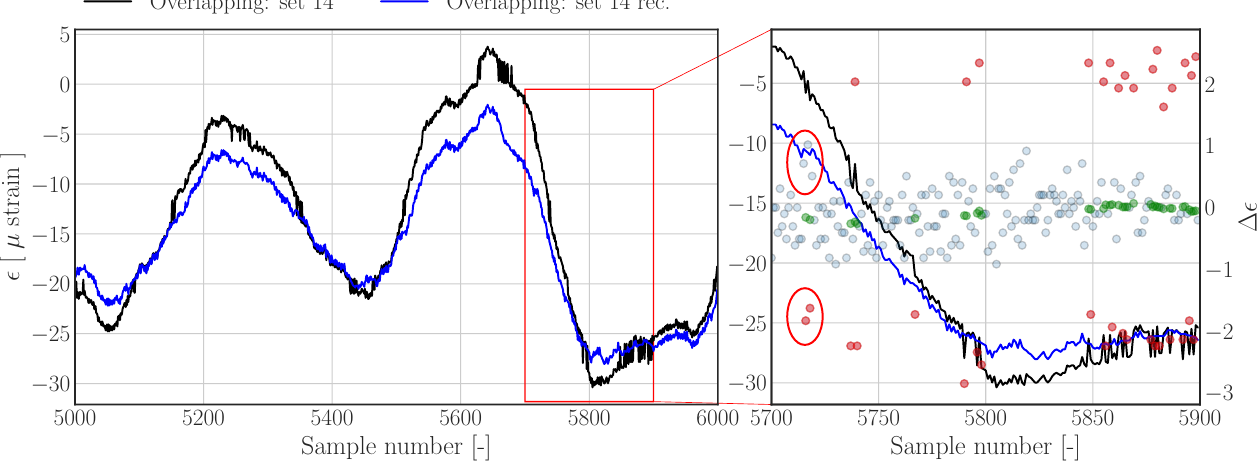
Figure 12. Left : Subset of data set 14 from Overlapping.hdf5 (dashed), and reconstructions (solid) using the Threshold filter based method . Right : Zoom in on region containing jumps. Nominal difference samples are indicated with blue dots, outliers and corresponding outlier replacements are indicated by red and green dots,